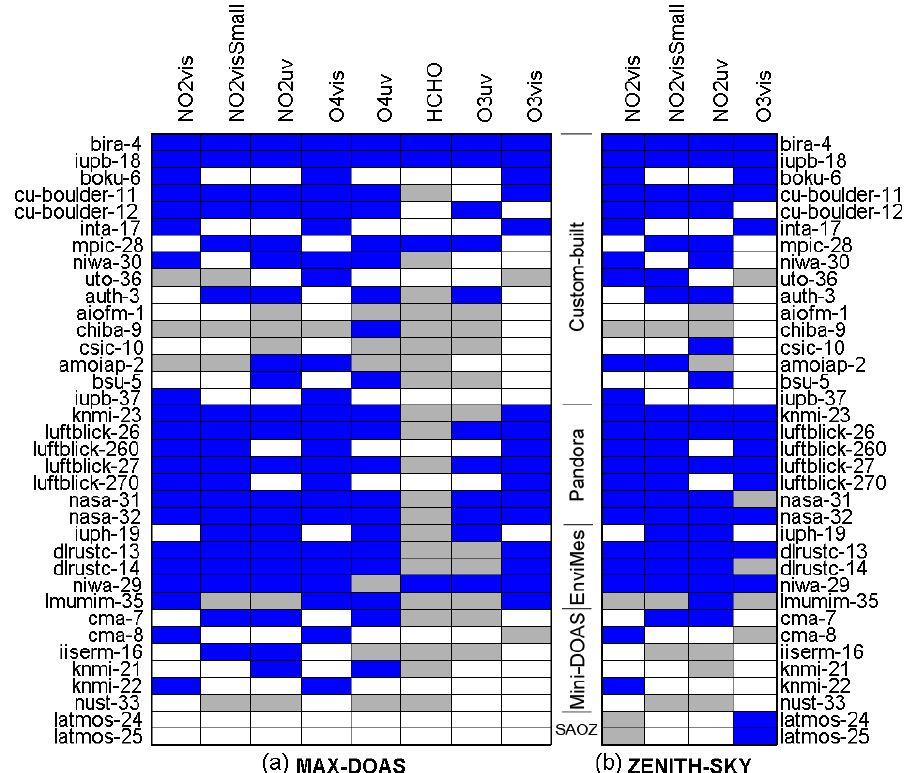
Figure 8. Instrument data sets selected to build the median MAX-DOAS reference (a) and zenith-sky (b) data sets. Blue marks the data sets included in the median, while grey marks the data sets not included and white the ones not available. Note that the instruments are grouped according to their specific design as custom-built, Pandora, EnviMes, Mini-DOAS or